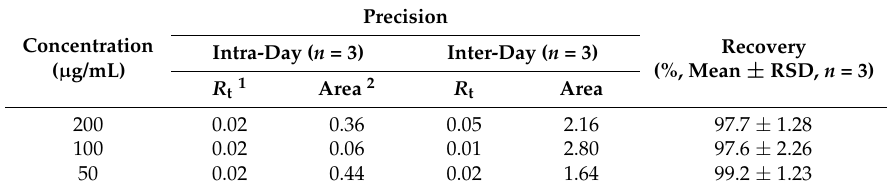
Table 2. Intra and inter day precision data for the retention time and peak area of α